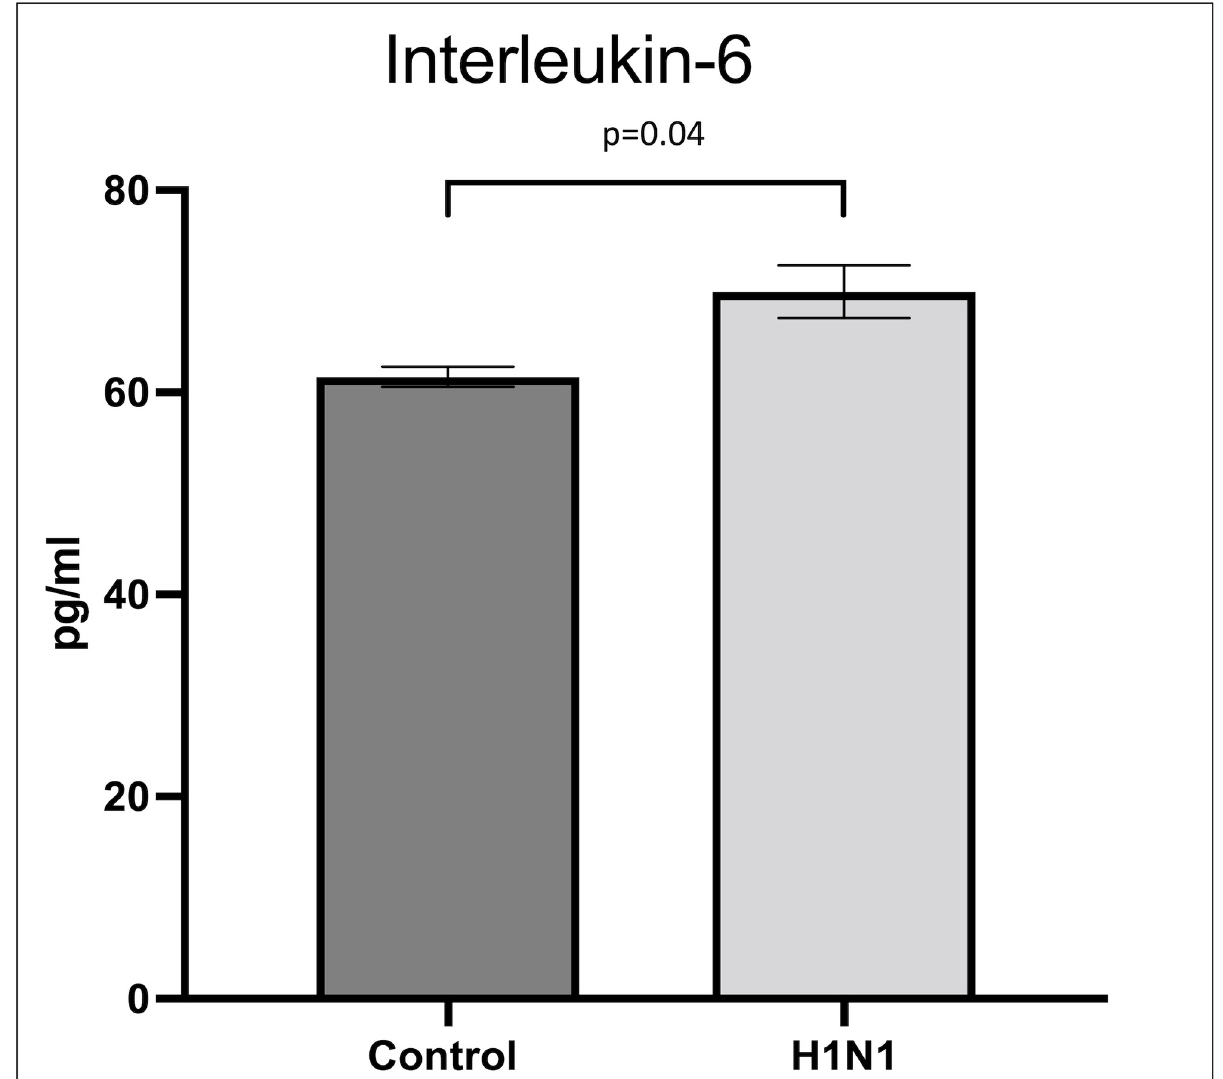
Fig 12. Comparison of Interleukin-6 levels. Interleukin-6 levels are increased in HUVECs after H1N1 influenza infection when compared to